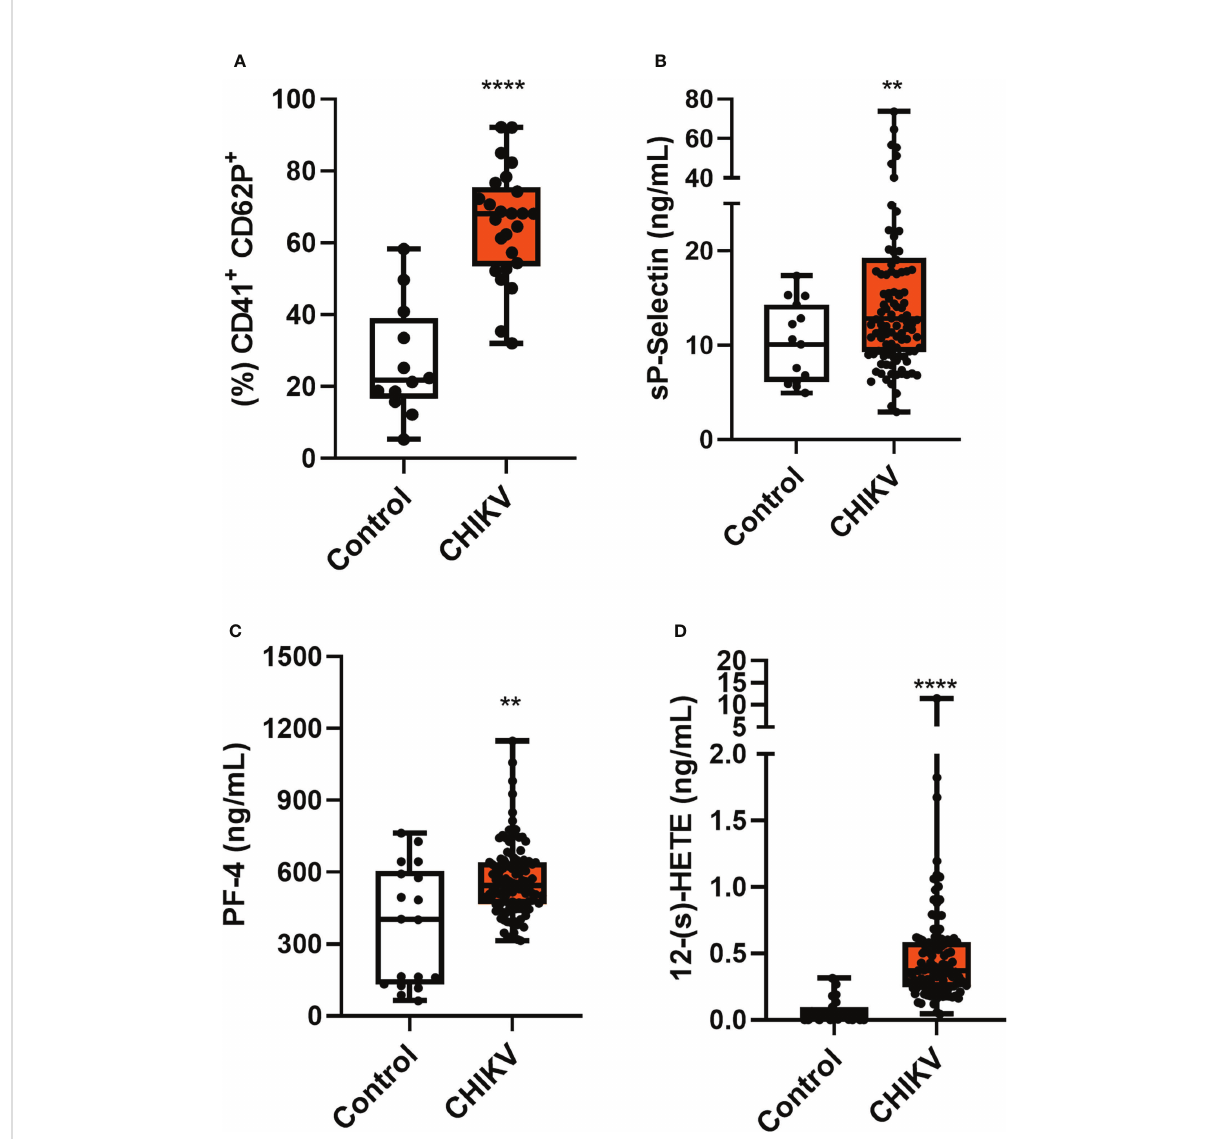
FIGURE 1 Chikungunya infection leads to platelet activation. (A) Analysis of CD62P expression on platelet surface by fl ow cytometry was performed in 25 patients and 12 controls, chosen randomly; (B) Plasma quantitation of the soluble molecule of CD62P; (C) Plasma quantitation of platelet factor 4 (PF-4); and (D) Plasma quantitation of 12-(S)-HETE. (B – D) Samples were collected from 132 (CHIKV) and 25 healthy volunteers (Control). The symbol ** means p<0.01 and the **** means